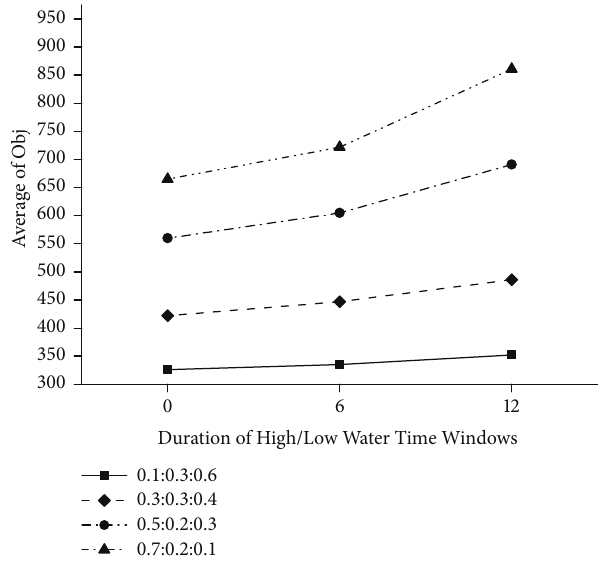
Figure 8: Tidal impact on vessel turnaround